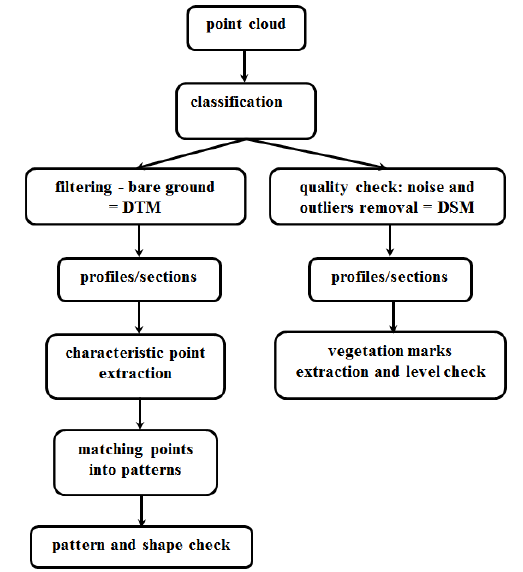
Fig. 4. The scheme of point cloud processing in settlement feature extraction